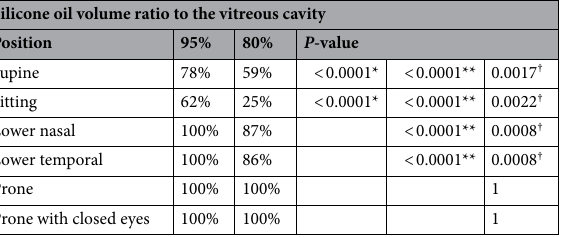
Table 3. Mean oil contact rates of the inferior-posterior retina. P -value* within 95% group, P -value** within 80% group, P -value † at 95% oil versus at 80%